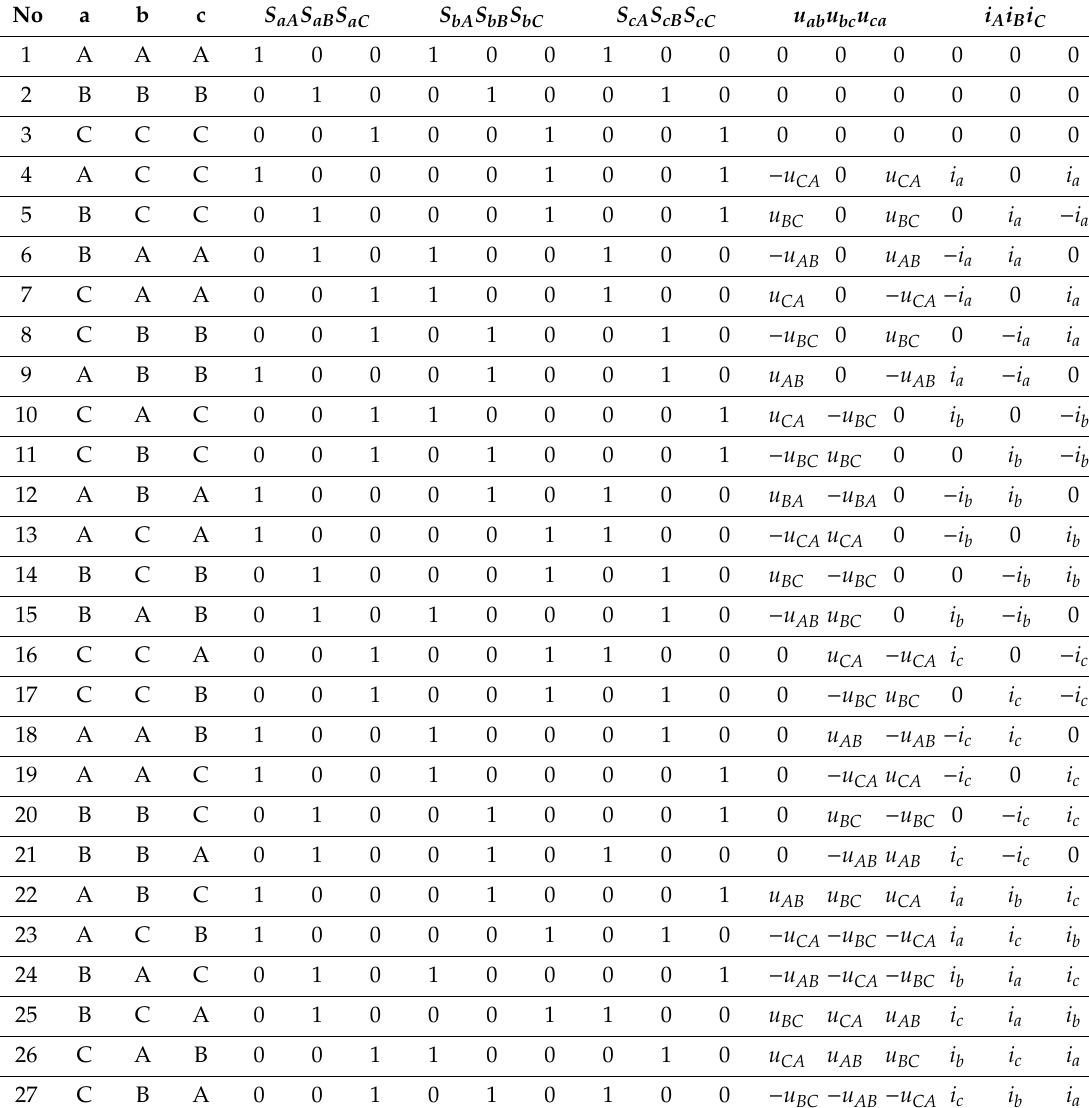
Table 1. Allowed configurations of matrix converter depending on the states of